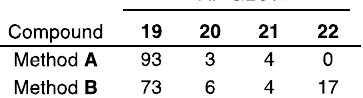
Figure 2. Suggested mechanistic pathway for the Pd/Cu-mediated dehydrogenative alkenylation of imidazoles. As already noted for Pd/Cu-mediated direct arylation reactions of 1,3-azoles with aryl halides [44–46], it is thought that an initial N-3 protonation or complexation with copper enhances the acidity of the C2-H bond, allowing a fast and regioselective pallada- tion to give the imidazole intermediate A . The subsequent regioselective carbopalladation